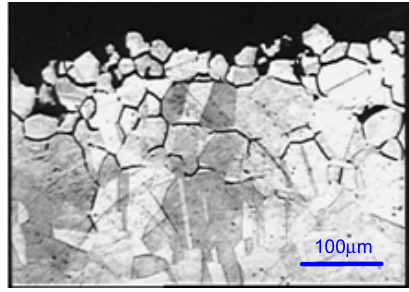
Figure 16. The interior of a corroded tube (#3, 1.4435/316L steel).